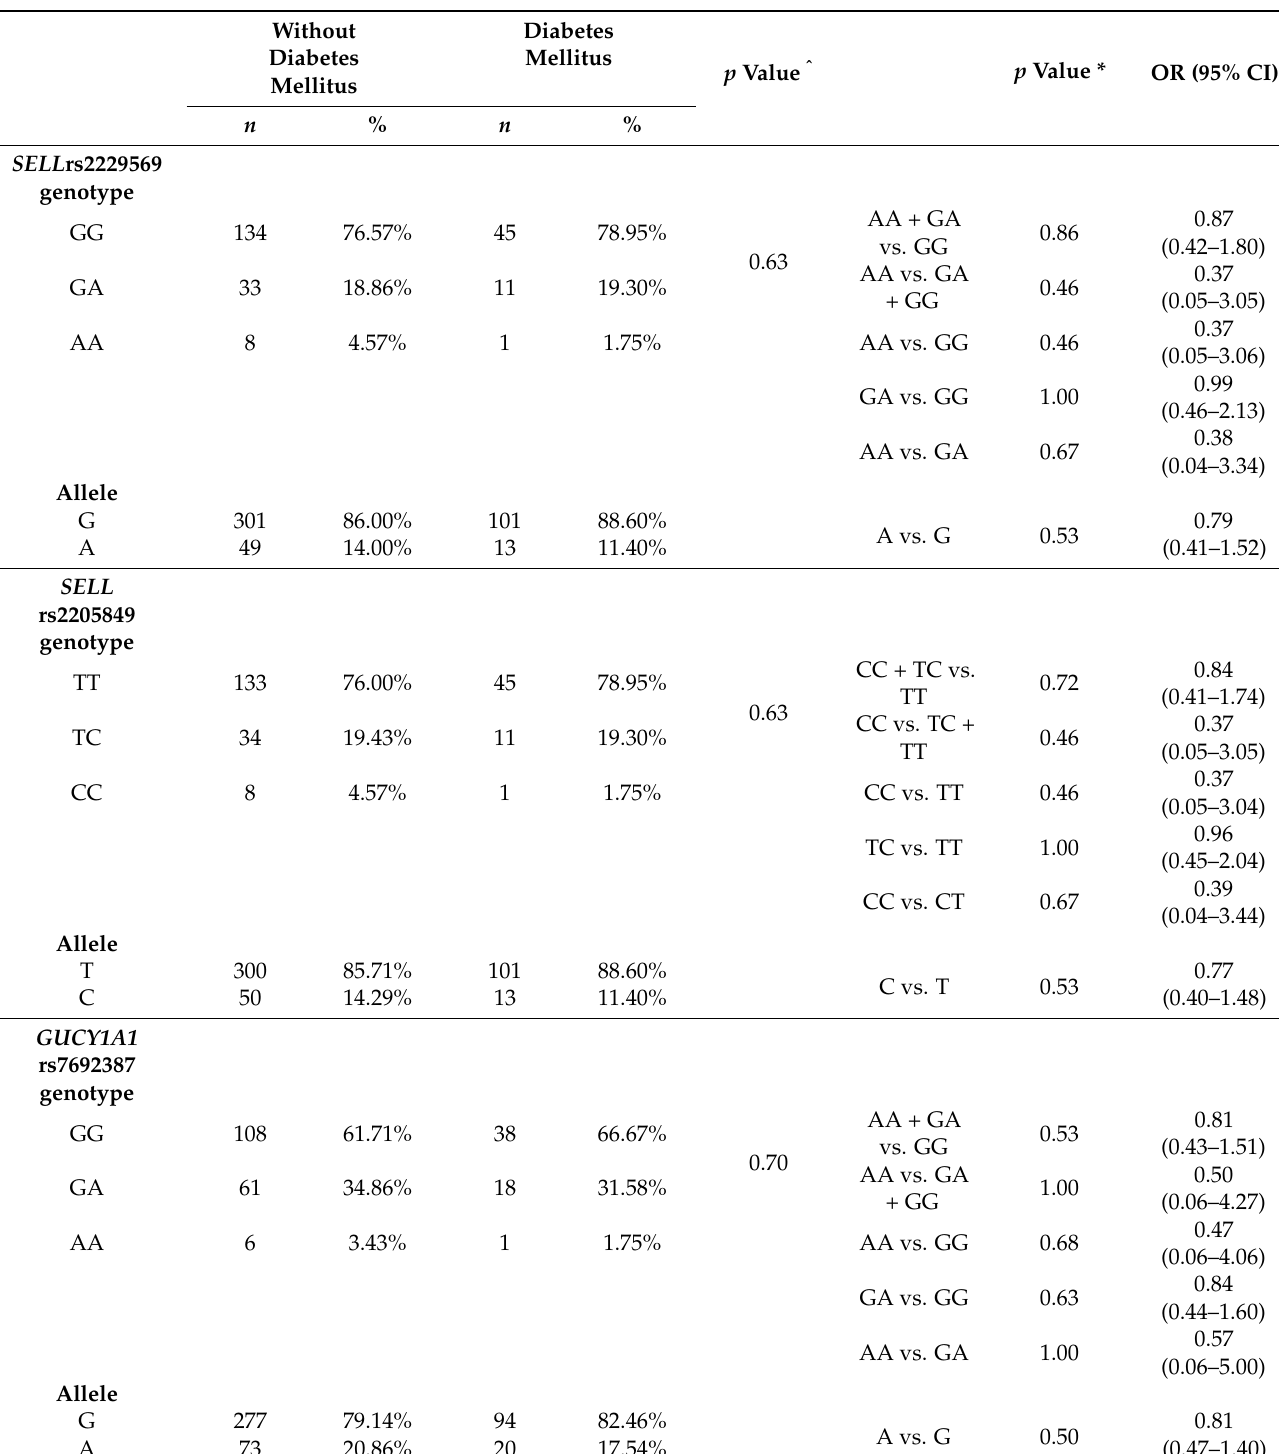
Table 5. Distributions of the SELL rs2229569, rs2205849 and GUCY1A1 rs7692387 genotypes and alleles in UA patients with and without diabetes mellitus